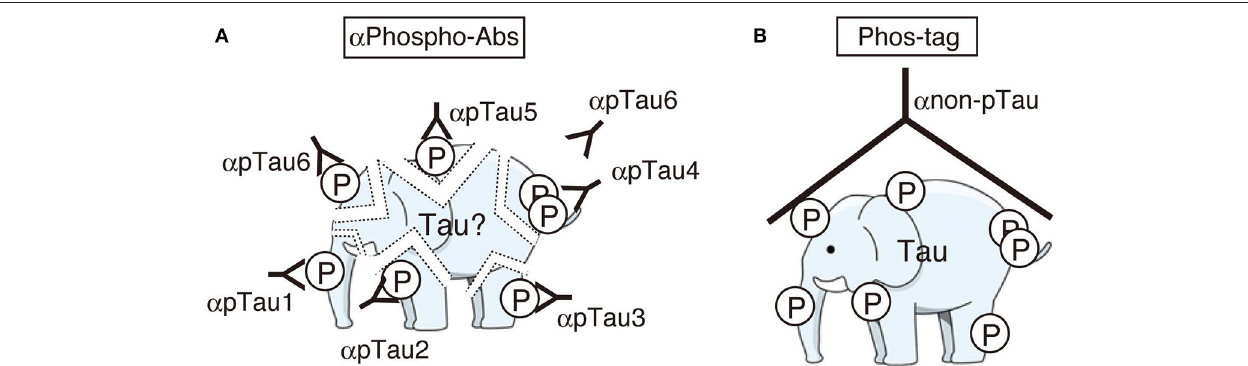
FIGURE 3 | Cartoons representing the images of immunoblotting with many phospho-specific antibodies (A) and a phosphorylation-independent single antibody after Phos-tag SDS-PAGE (B) . Phosphospecific antibodies detect only part of phosphorylation at each site and some sites can be masked by another phosphorylated site nearby (here the site for α pTau6 is masked by a phosphorylated site which reacts with α pTau4). Phos-tag shows the whole phosphorylation profile at once. An illustration of an elephant was downloaded from the free illustration site at: http://illpop.com/png_animalhtm/elephant_a04.htm.